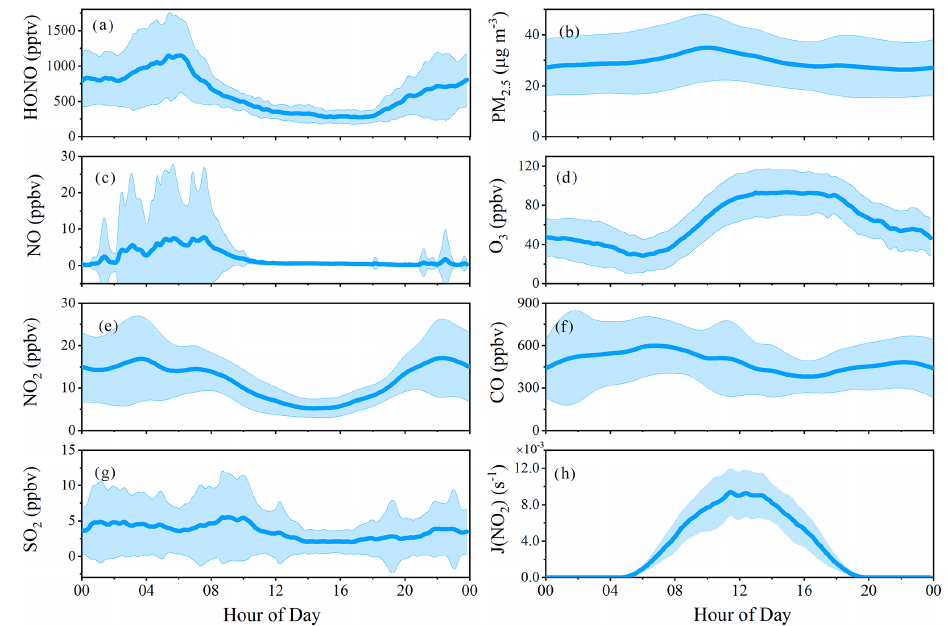
Figure 3. Average diurnal profiles of HONO and related species measured during the campaign. Note that some of these data were also shown in the companion ACP paper for comparison between measurements at the foot and the summit stations.